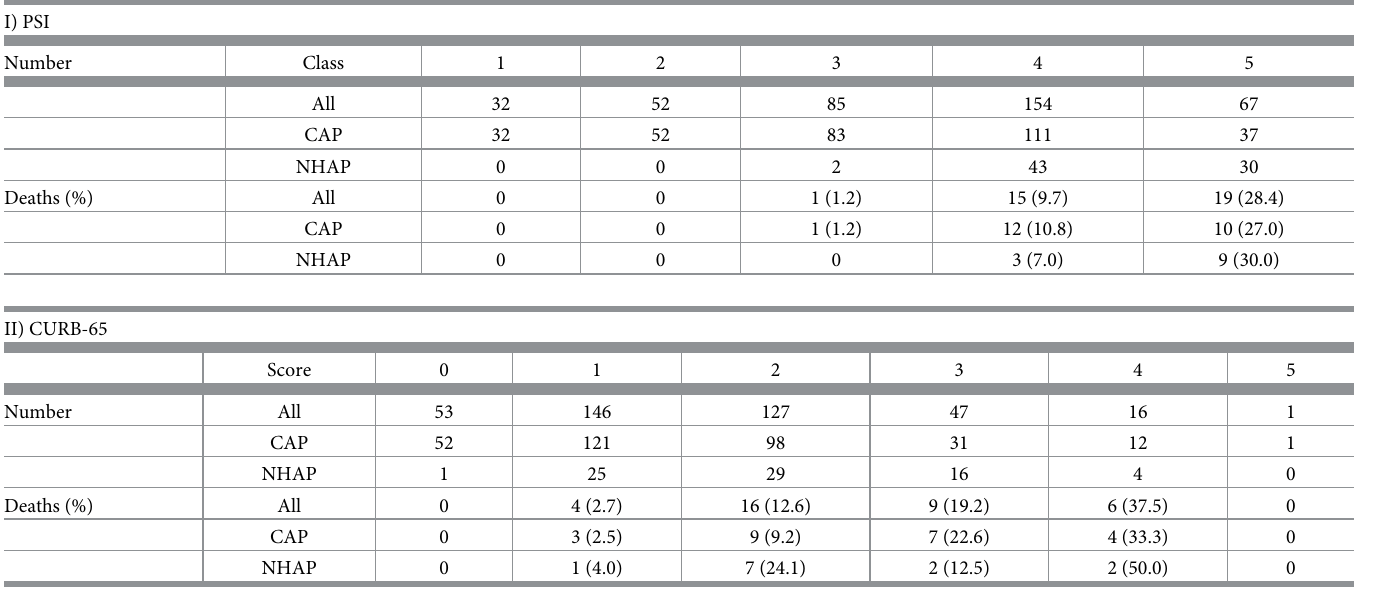
Table 2. The prognostic power of PSI and CURB-65 for in-hospital death of pneumonia.